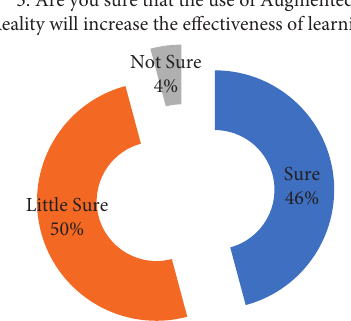
Figure 7: Teachers’ optimism on using AR.